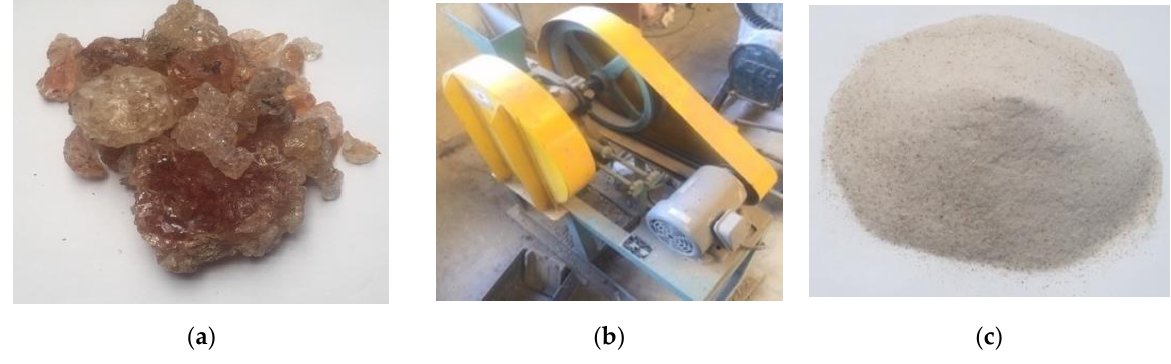
Figure 2. ( a ) Gum Arabic; ( b ) jaw crusher engine machine; ( c ) gum Arabic granules.